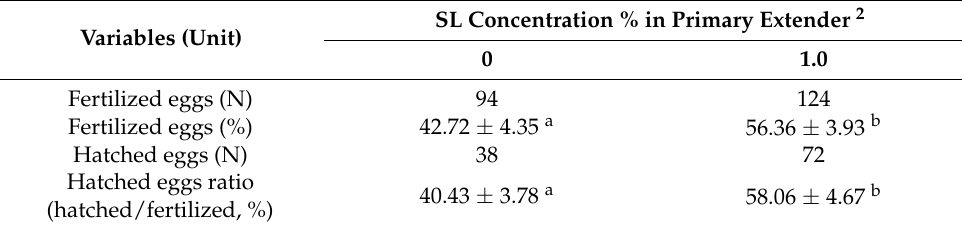
Table 4. Evaluation of fertility and hatchability rates of post-thawed rooster sperm treated with soybean lecithin (SL).